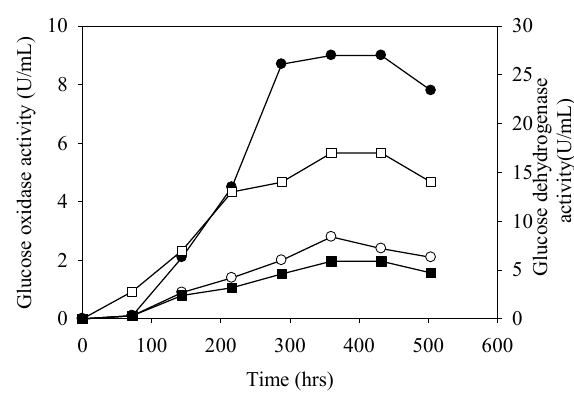
Figure 2. A typical time course of enzyme synthesis on during the fermentation. Symbols represent: (●) glucose oxidase from A.niger UV-112; (○) glucose oxidase from A.niger RP- 11; (□) glucose dehydrogenase A.niger UV-112 and (